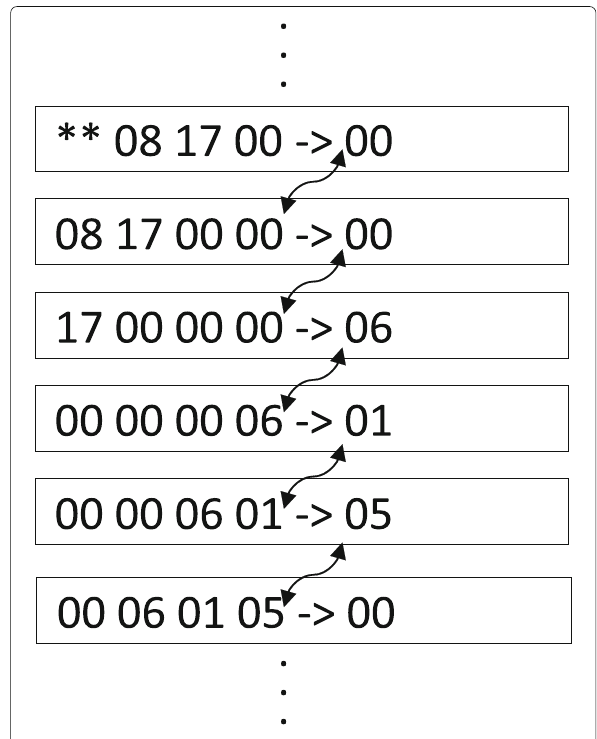
Fig. 5 The prediction process. Prediction of the next value by LSTM based on the previous content